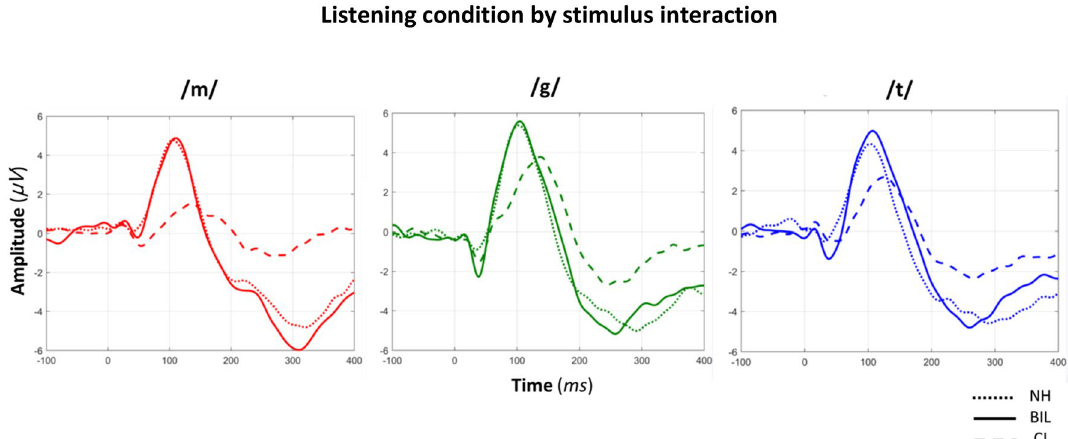
Figure 4. Grand average CAEP waveforms elicited by each stimulus (/m/, /g/, /t/) in the three listening conditions [NH, BIL (NH + CI), CI (NH masked)], depicting the non-significant listening condition by stimulus interaction for P1 latency ( p = 0.524) and amplitude ( p = 0.405).